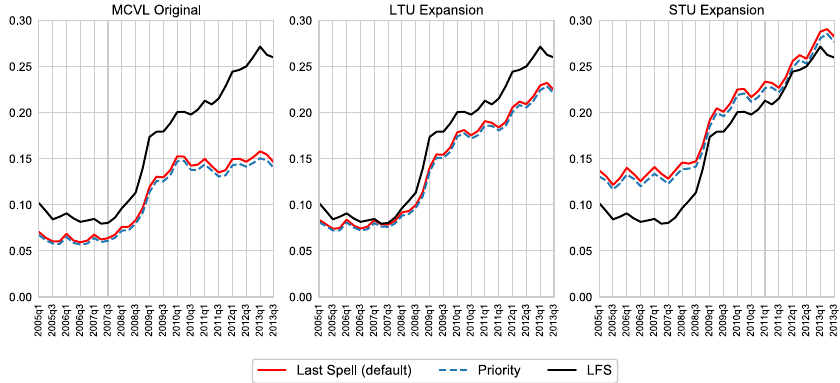
Fig. 15 Different choosing criteria, by expansion. Source : MCVL and the